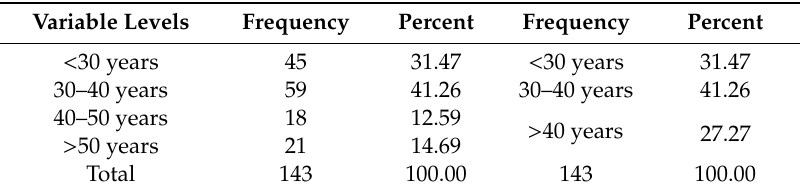
Table 1. Analysis of the frequency of a variable: age. Variable Levels Frequency Percent Frequency Percent < 30